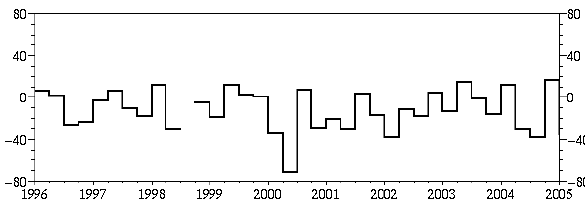
Fig. 5. Distribution of differences between the numbers of the eastern and the western CMEs, calculated for 3-month periods of SOHO LASCO observations.